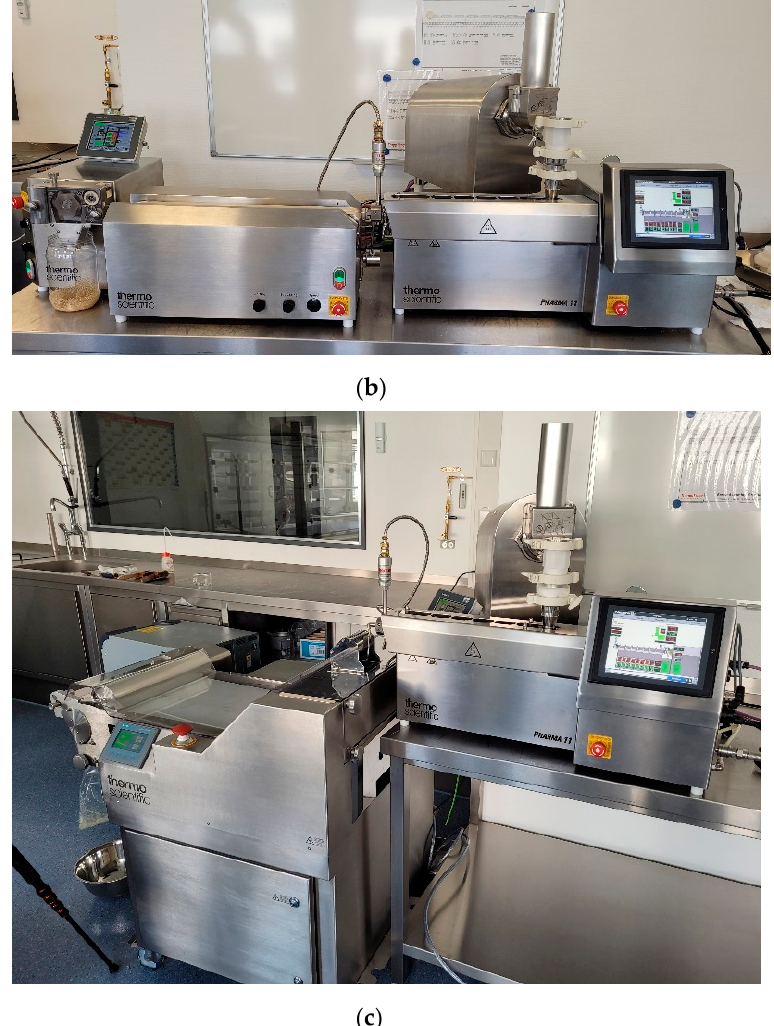
Figure 2. ( a ). Photograph of the manufacturing set-up for the HCF feedstock. ( b ). Photograph of the manufacturing set-up for the PE feedstock. ( c ). Photograph of the manufacturing set-up for the CRF feedstock.